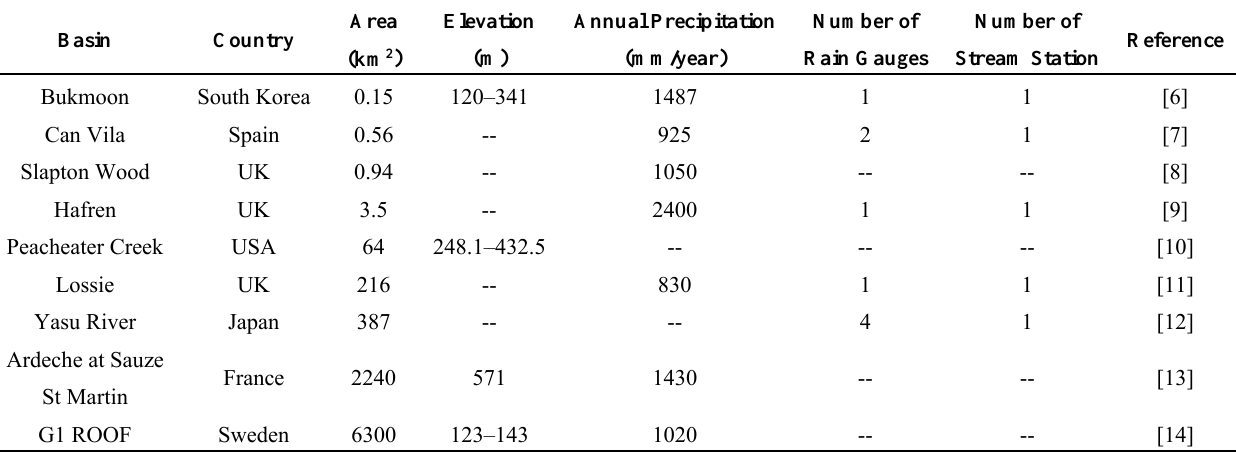
Table 1. Some applications of TOPMODEL to different